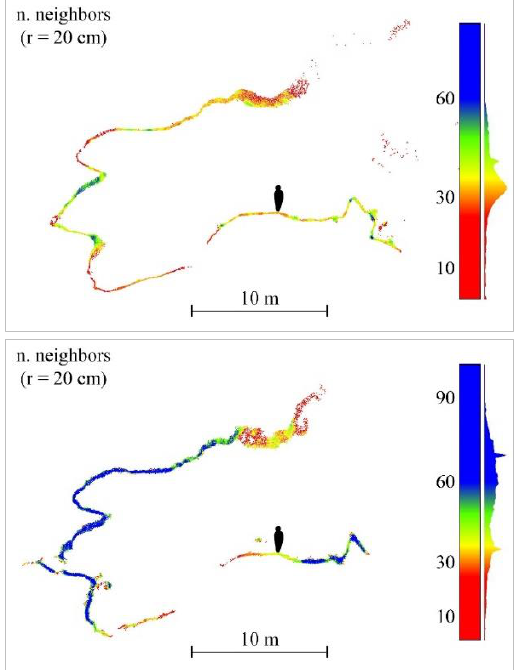
Figure 6. Density of the point clouds calculated for a section of Trona Grande. Top: Ant3D, bottom: Heron Backpack.